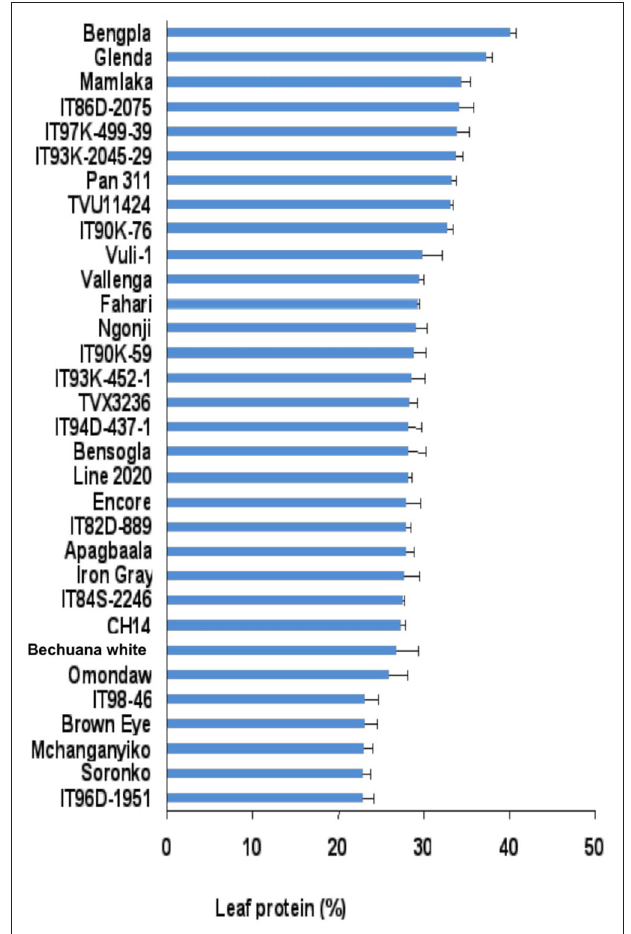
FIGURE 1 | Total leaf protein of 32 cowpea varieties at Taung, South Africa in